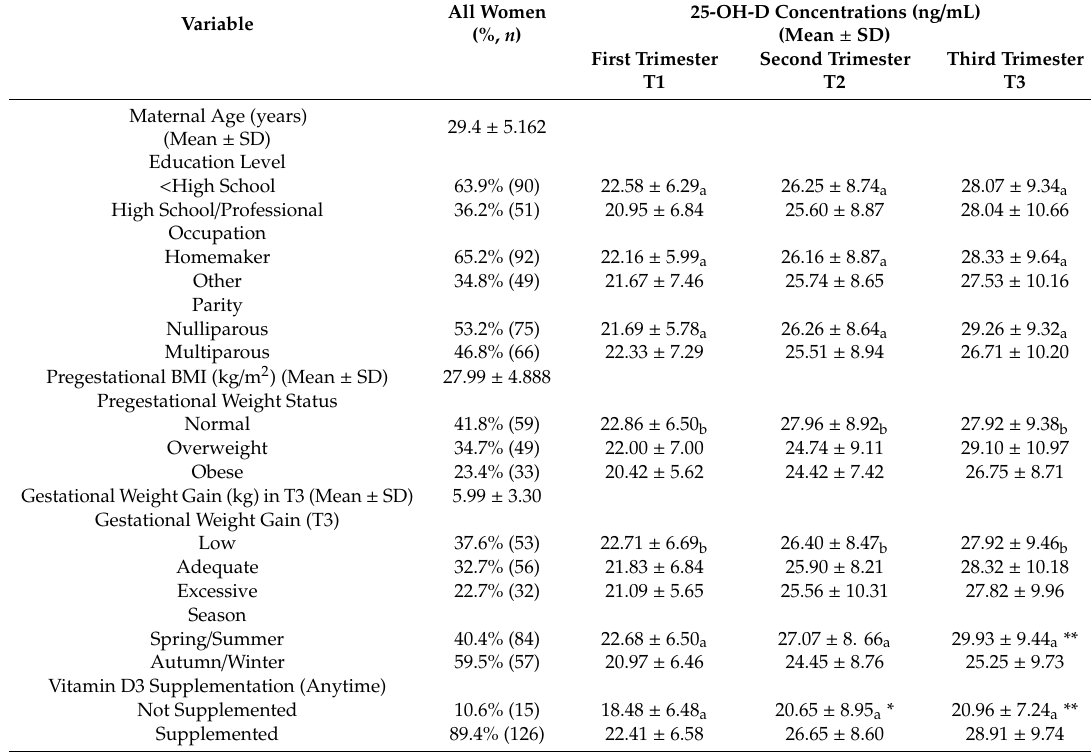
Table 1. Maternal 25-OH-D concentrations during pregnancy according to sociodemographic and clinical